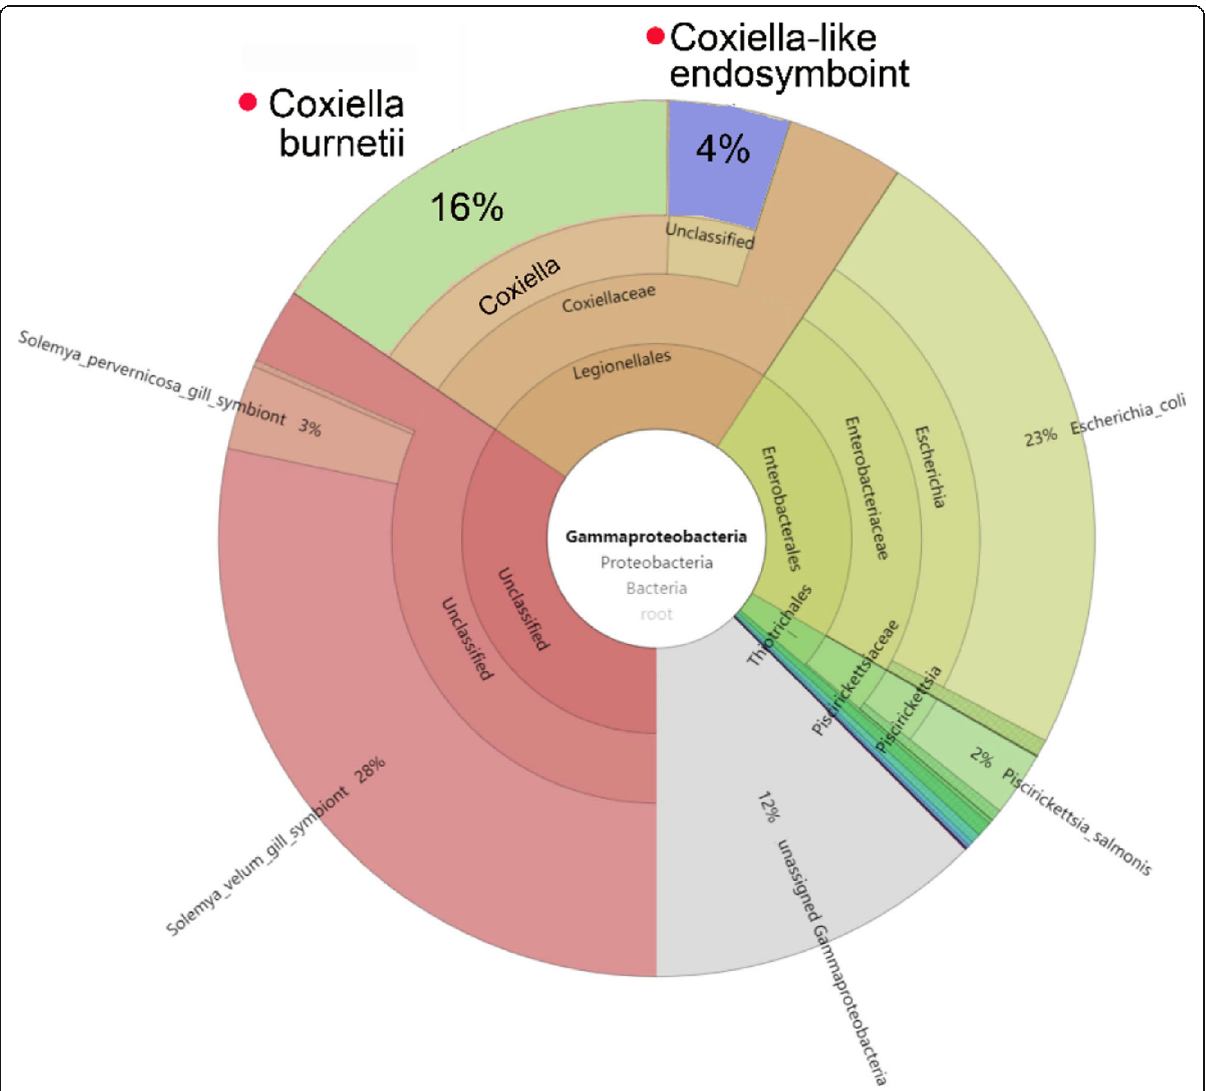
Fig. 3 Hierarchical classification and distribution of various species belonging to Gammaproteobacteria detected in tick specimens using KRONA extension. The red dots indicate pathogens that can infect